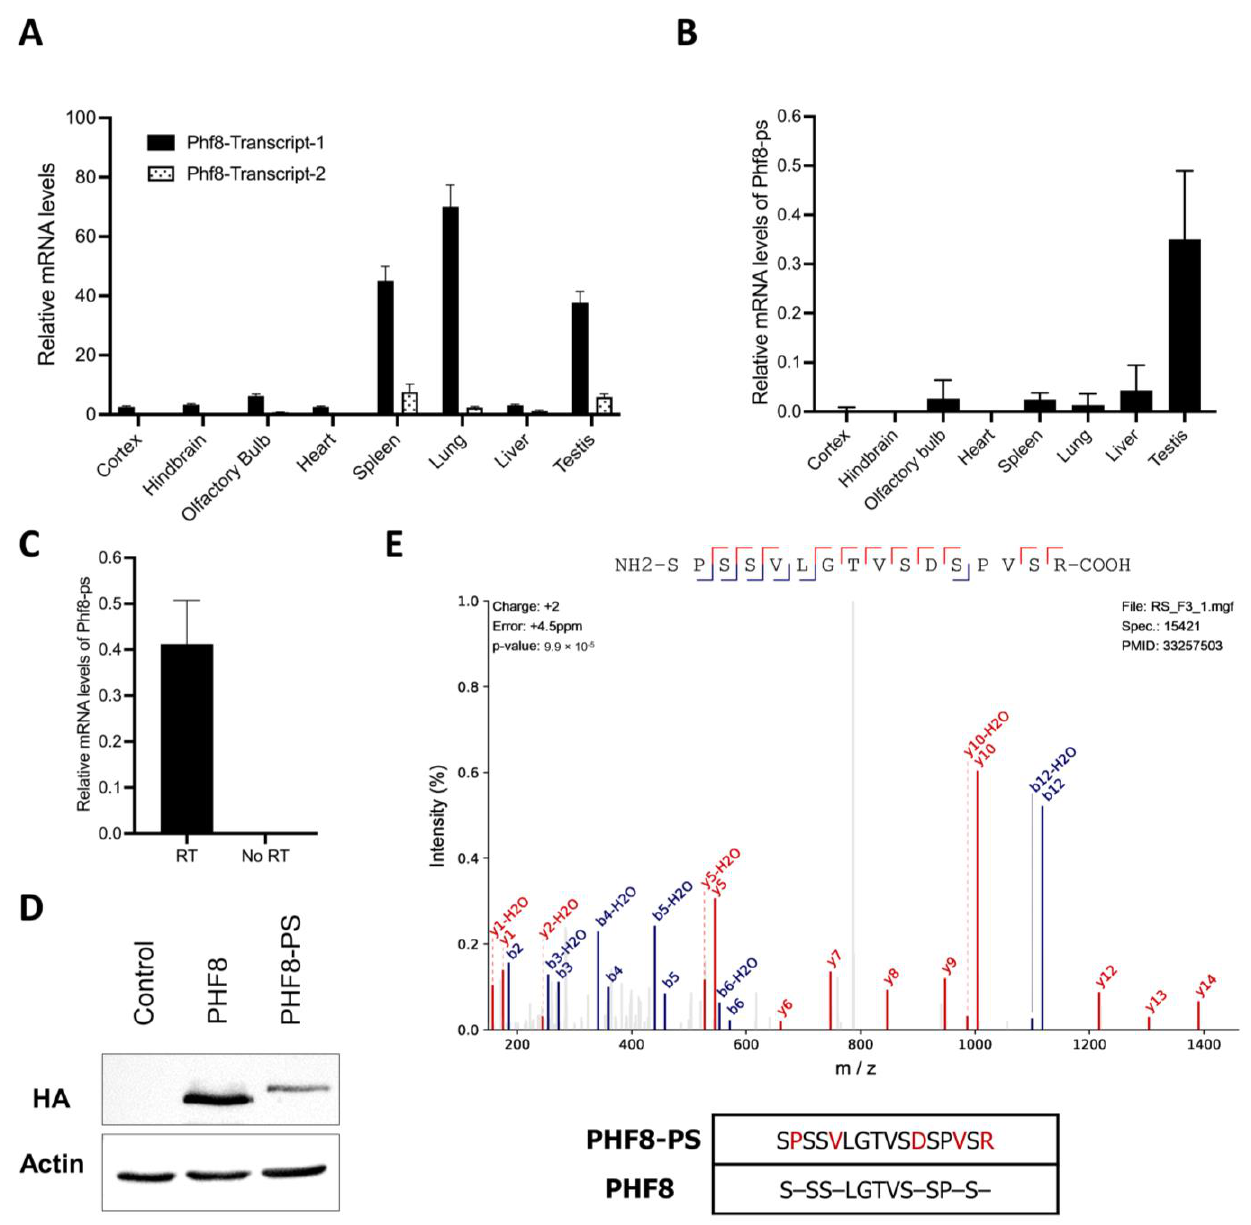
Figure 2. Phf8-ps mRNA and protein expression. ( A , B ) Relative mRNA levels of ( A ) Phf8 transcripts 1 and 2 and ( B ) Phf8-ps transcript were measured in different mouse organs or tissues by quantitative PCR and normalized to that of GAPDH (n = 3 per organ/tissue). ( C ) Relative mRNA levels of Phf8-ps transcript were measured by quantitative PCR using on cDNA from testis samples prepared with or without reverse transcriptase. Levels were normalized to mRNA levels of GAPDH (n=3 per condition). ( D ) NIH3T3 cells were transfected to transiently overexpress HA/FLAG-tagged PHF8 and PHF8-PS. Protein levels of PHF8 and PHF8-PS were analyzed by Western blotting as indicated. ( E ) Peptide spectrum of a unique PHF8-PS peptide (SPSSVLGTVSDSPVSR). This unique peptide was found in the dataset of mouse germ cell proteome [40]. The sequence homology between this PHF8-PS peptide and PHF8 protein is represented at the bottom panel.